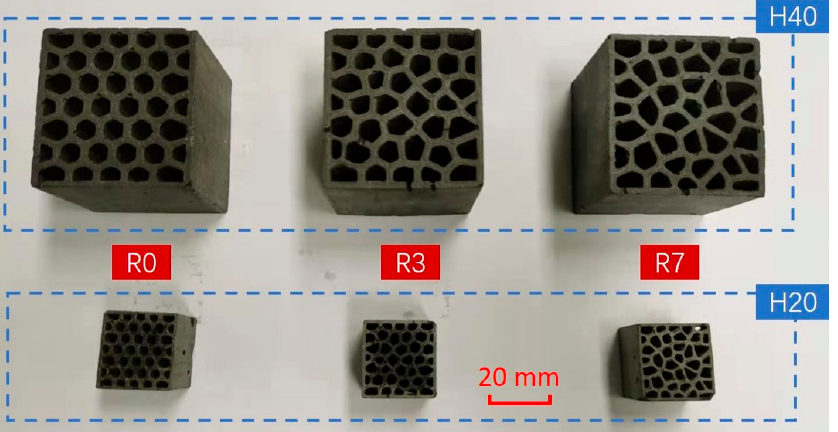
Figure 8. Specimen fabrication working flow of the indirect 3D printing method.